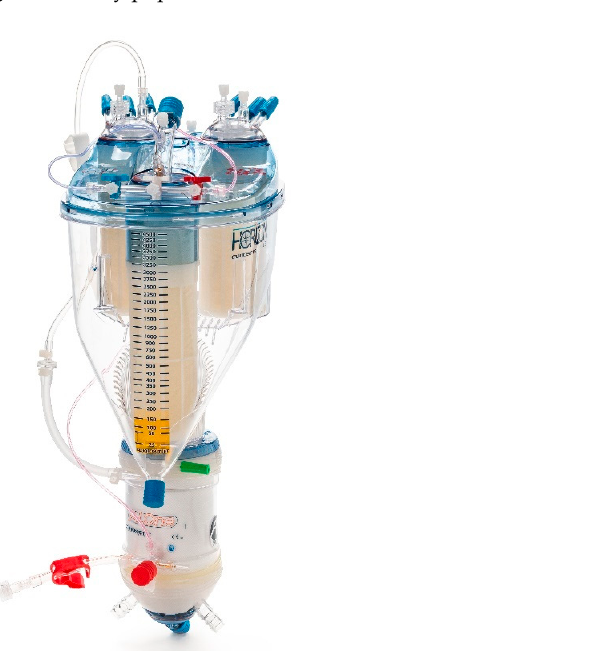
Figure 2. Horizon AF PLUS, Eurosets (venous reservoir and oxygenator).